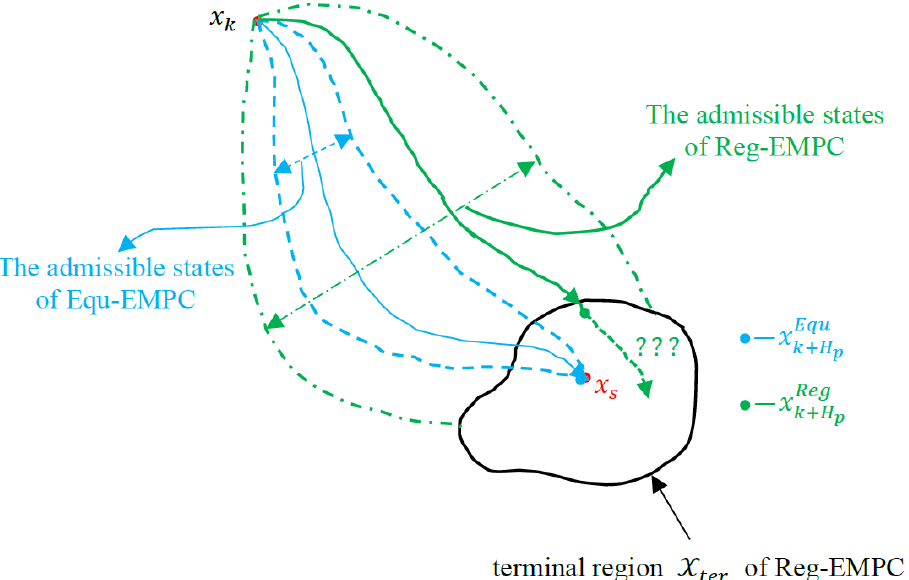
Figure 1. Improvements in operation performance using Equ-EMPC and Reg-EMPC.